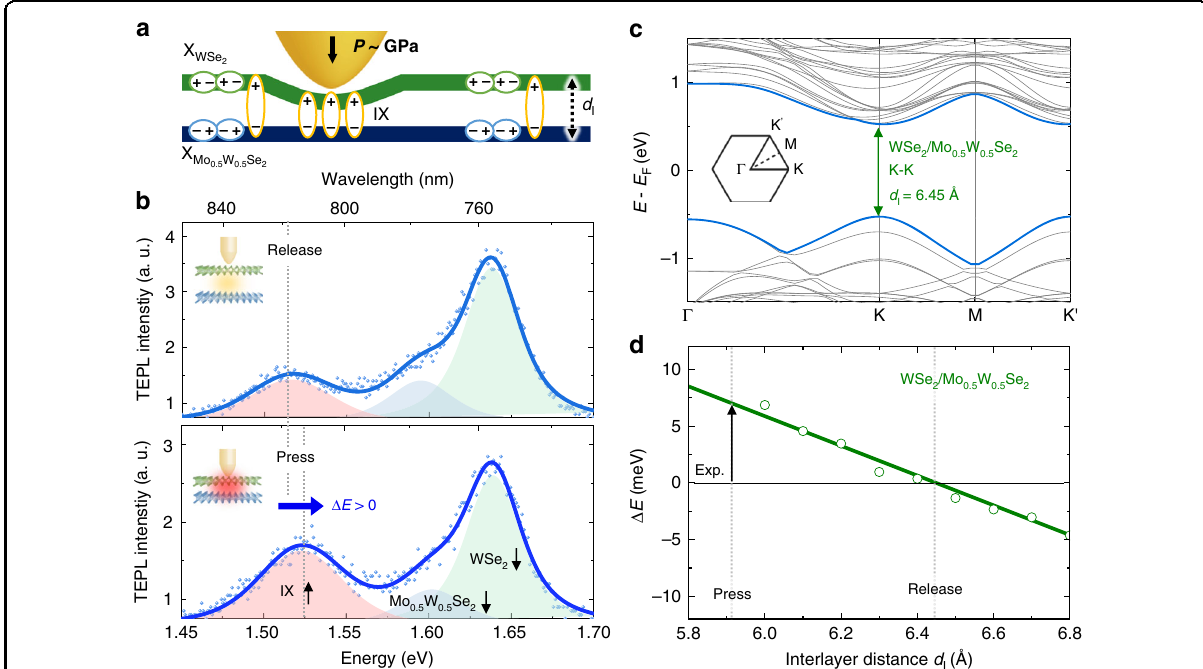
Fig. 3 Tip-induced control of interlayer coupling strength and simulated electronic bandstructures. a Schematic illustration of the local tip control of the interlayer distance d I in a WSe 2 /Mo 0.5 W 0.5 Se 2 heterobilayer. b TEPL spectra before (top) and after (bottom) pressing the heterobilayer with GPa scale tip-pressure, which causes signi fi cant modi fi cations in electronic bandstructure. c Electronic bandstructure calculated via DFT for a WSe 2 /Mo 0.5 W 0.5 Se 2 heterobilayer (gray) at equilibrium interlayer distance d I = 6.45 Å , with the highest valence and lowest conduction bands highlighted in blue; the direct K-K transition is indicated with green arrow; inset shows high-symmetry points in the hexagonal Brillouin zone. The Fermi energy E F is de fi ned as an averaged energy of the conduction band minimum and the valence band maximum. d Calculated energy shift for the K-K transition in a